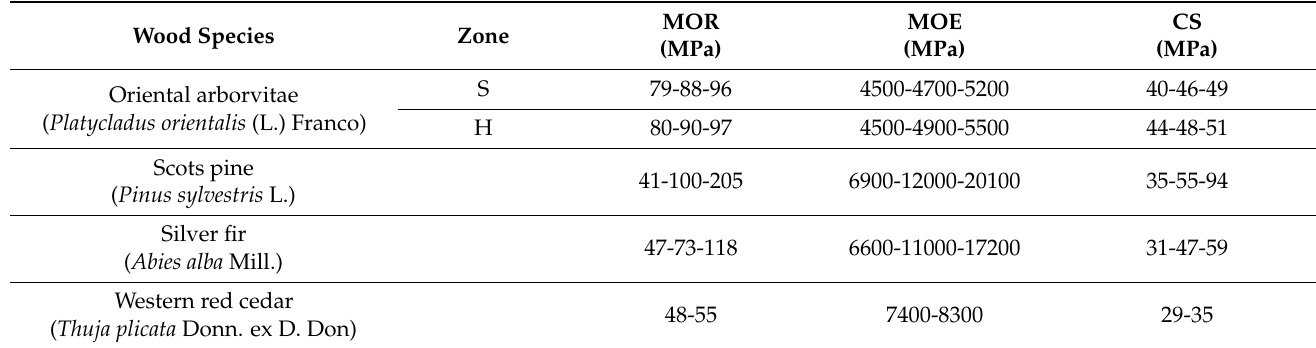
Table 3. Mechanical properties of oriental arborvitae wood compared with the properties of other species according to Wagenführ [38];